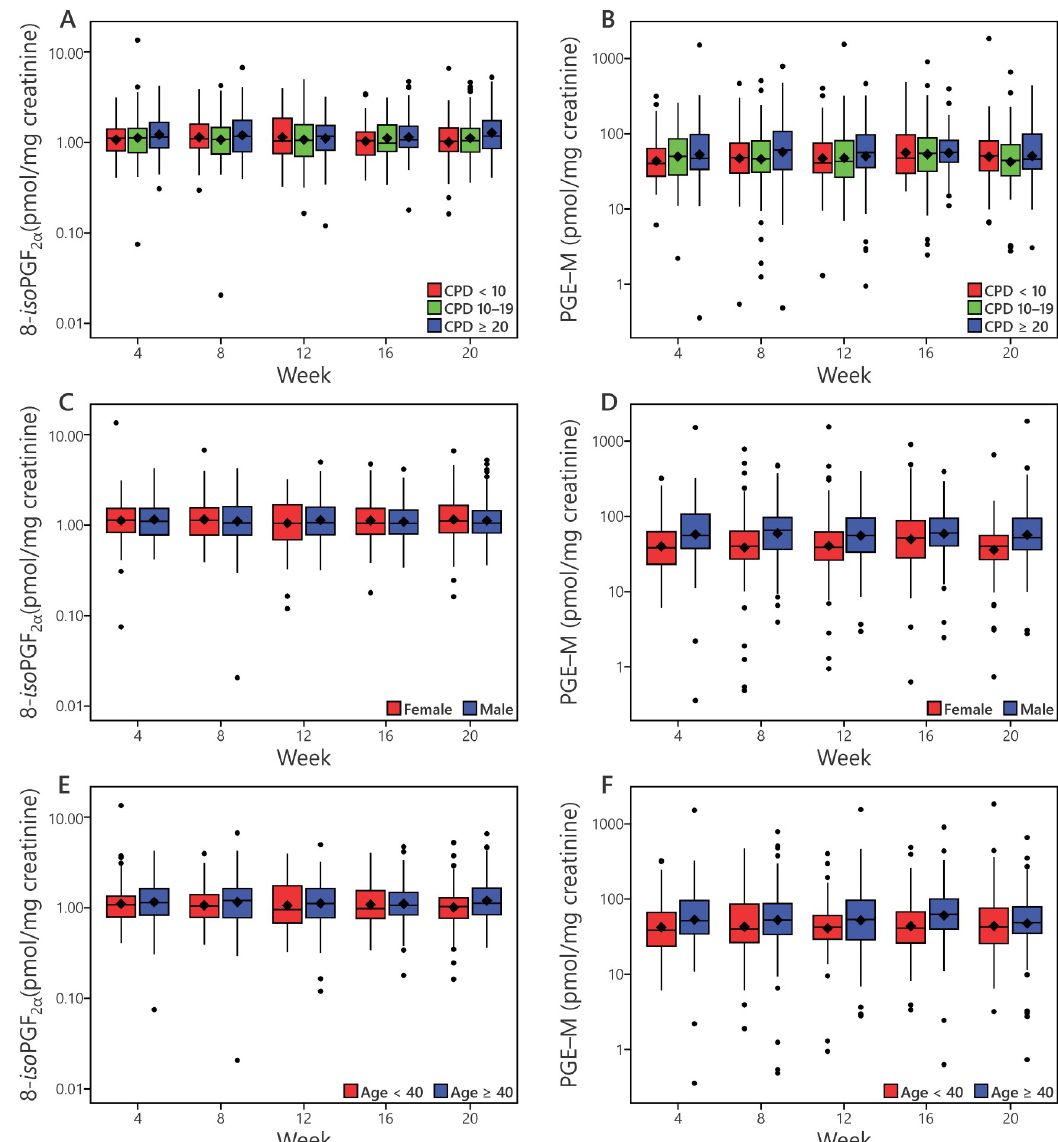
Fig 3. Effects of cigarettes per day (CPD) (panels A, B), gender (panels C, D), and age (panels E, F) on levels of 8- iso -PGF 2 α and PGE-M. The effects of CPD on 8- iso -PGF 2 α (p = 0.02), and gender (p < 0.0001) and age (p < 0.01) on PGE-M were significant. See also legend of Fig 2